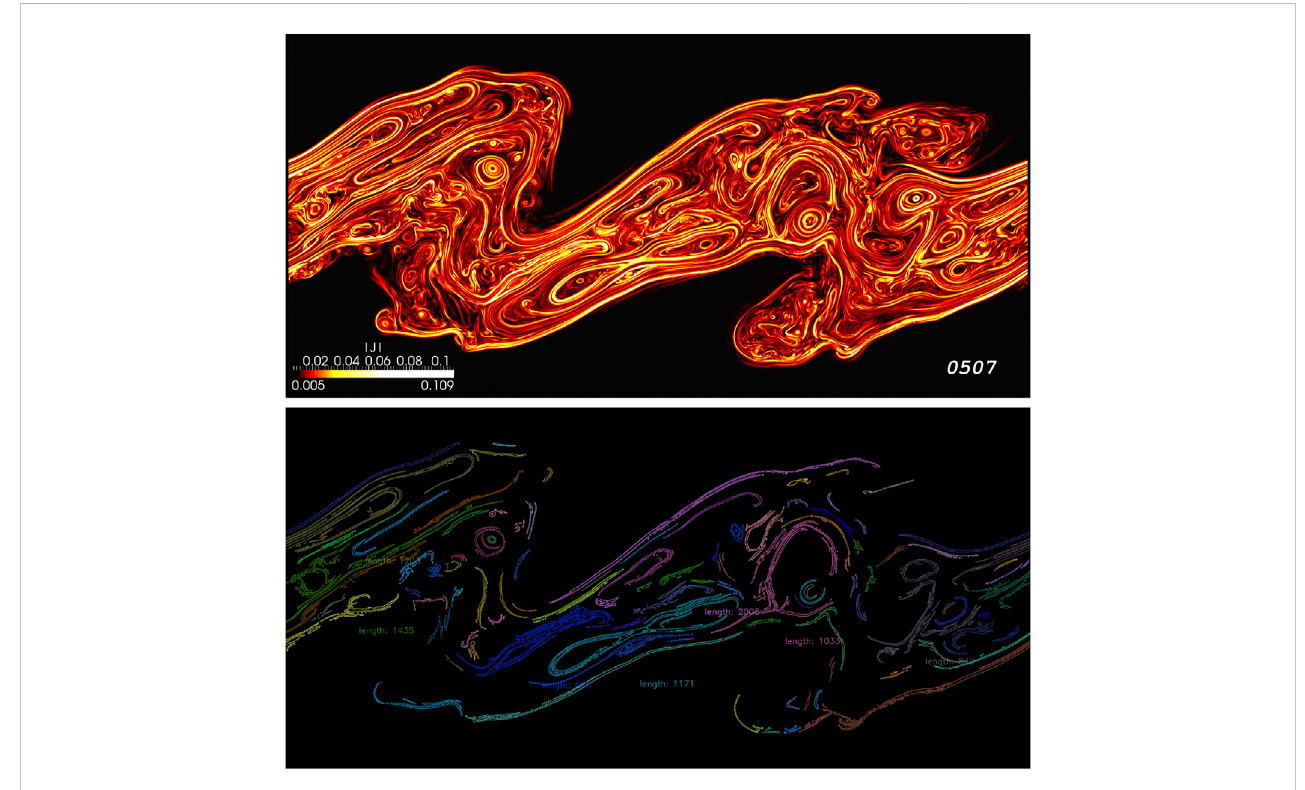
FIGURE 1 (A) Intensity plot of current density, (B) Automated detection and length measurements of current